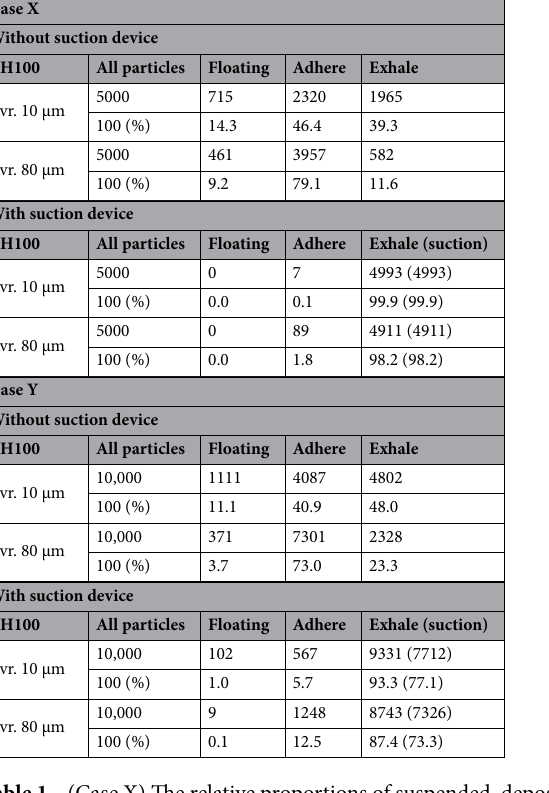
Table 1. (Case X) The relative proportions of suspended, deposited, exhaled, and suctioned particles in the presence and absence of a suction device, 100 s after the patient begins exhaling at a constant rate of 2.5 m/s and assuming no evaporation (100% relative humidity; RH100). (Case Y) The relative proportions of suspended, deposited, exhaled, and suctioned particles in the presence and absence of a suction device positioned as shown in Supplementary Fig. S3, 30 s after the patient completes 10 consecutive coughs modeled by the air velocity profile shown in Supplementary Fig. S2 at